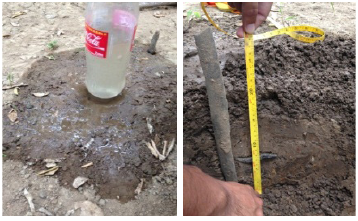
Figure 3. (Search for effective roots)